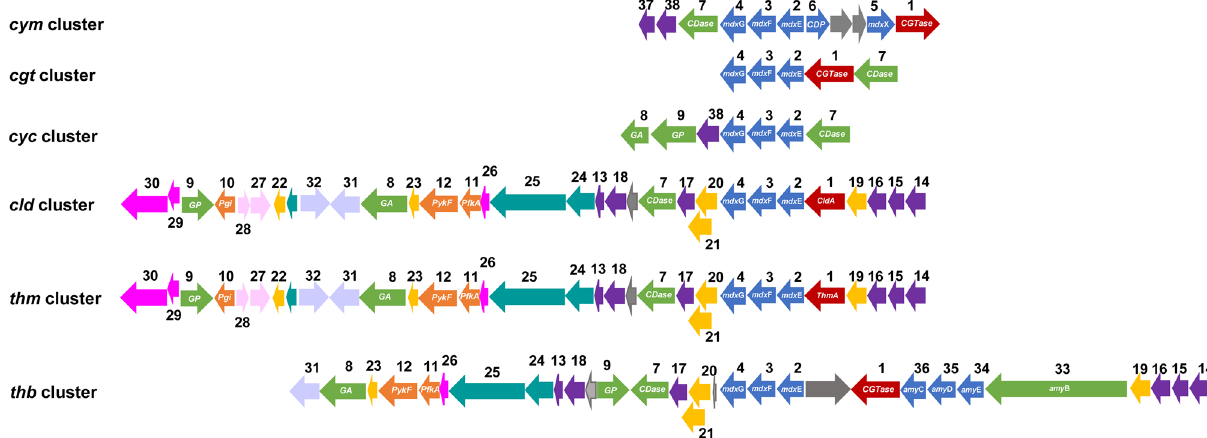
Figure 4. Comparative view of the gene clusters involved in the CM-CD pathway. Note the genetic organization of the CM-CD gene clusters from K. oxytoca ( cym ), Thermococcus sp. ( cgt ), B. subtilis ( cyc ), C. subterraneus ssp. ( cld ), Thermoanaerobacter spp. ( thm ), and Thermoanaerobacterium spp. ( thb ). Additionally, note the protein-encoding genes involved in the four steps of the CM-CD pathway. (i) Synthesis: CGTases (1, red). (ii) Translocation/Internalization: MdxE (2), MdxF (3), and MdxG (4) in blue. While the MdxX (5) and CDP (6) from G− K. oxytoca ( cym ) are also blue, the putative msm X-encoding gene is not included. (iii) Degradation: CDase (7), GA (8), and GP (9) in green. (iv) Metabolic assimilation: Pgi (10), PfkA (11), and PykF (12) in orange. AmyB (33) and the AmyEDC transporter system (34–36) from Thermoanaerobacterium spp. ( thb ), and the putative transcriptional regulator of the ABC transporter system from cym / cyc (37–38) are shown. Note the five groups of protein-encoding genes that are essential for several prokaryotic cell functions: (i) HPr (13), PolIIIα (25), and the CBS domain/Bateman module (24) for carbon catabolite regulation, bacterial genome replication, and sensing cellular energy status, metal ion concentration, and ionic strength. (ii) MurB (14), PHP (15), RapZ (16), RodZ (17), and WhiA (18) for cell wall biogenesis, sporulation, and cell division. (iii) feruloyl esterase (22), 2-phospho-l-lactate transferase (19), the enzyme system (R)-2-hydroxyglutaryl-CoA dehydratase (20, 21), and 4-hydroxy benzoyl-CoA thioesterase (23) for oxidative stress defense, degradation of aromatic compounds, and fatty acid metabolism. (iv) signal-transducing protein PII (26), methylenetetrahydrofolate reductase (29), methionine synthase (30), PepT (27) and the anaerobic transcriptional activator fnr (28) for amino acid metabolism. (v) tRNA(m 5 U 54 )methyltransferase (31) and MATE (32) for tRNA maturation and detoxification. Genes of unknown function are in gray. Abbreviations are listed in Table